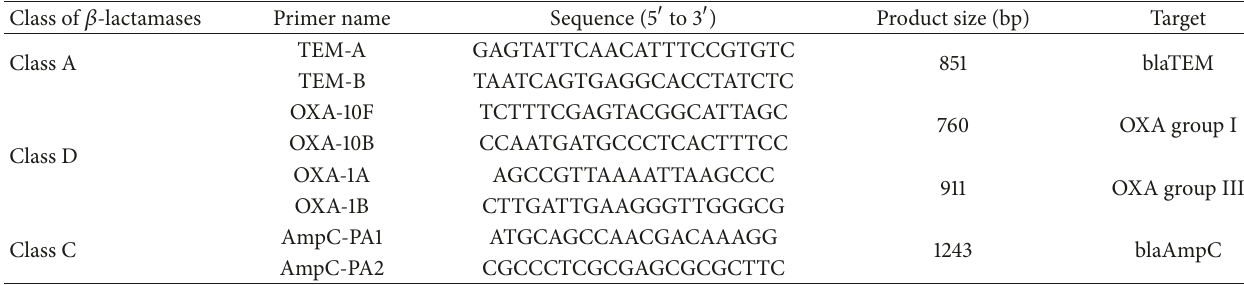
Table 1: Primers sequences used in the amplification and antimicrobial resistance genes in P. aeruginosa .